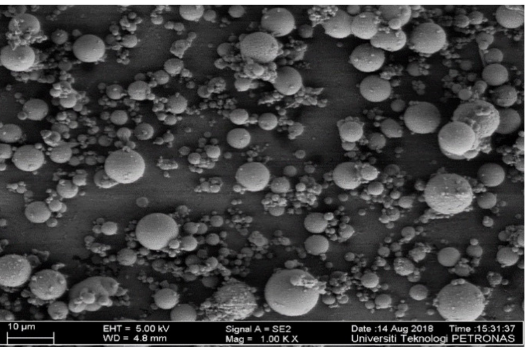
Figure 1. Field emission scanning electron microscope (FESEM) of fly ash